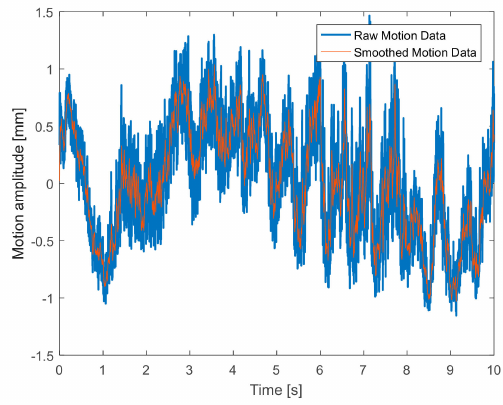
Figure 9. Detected movement ( x(t) ) under accelerated breath.